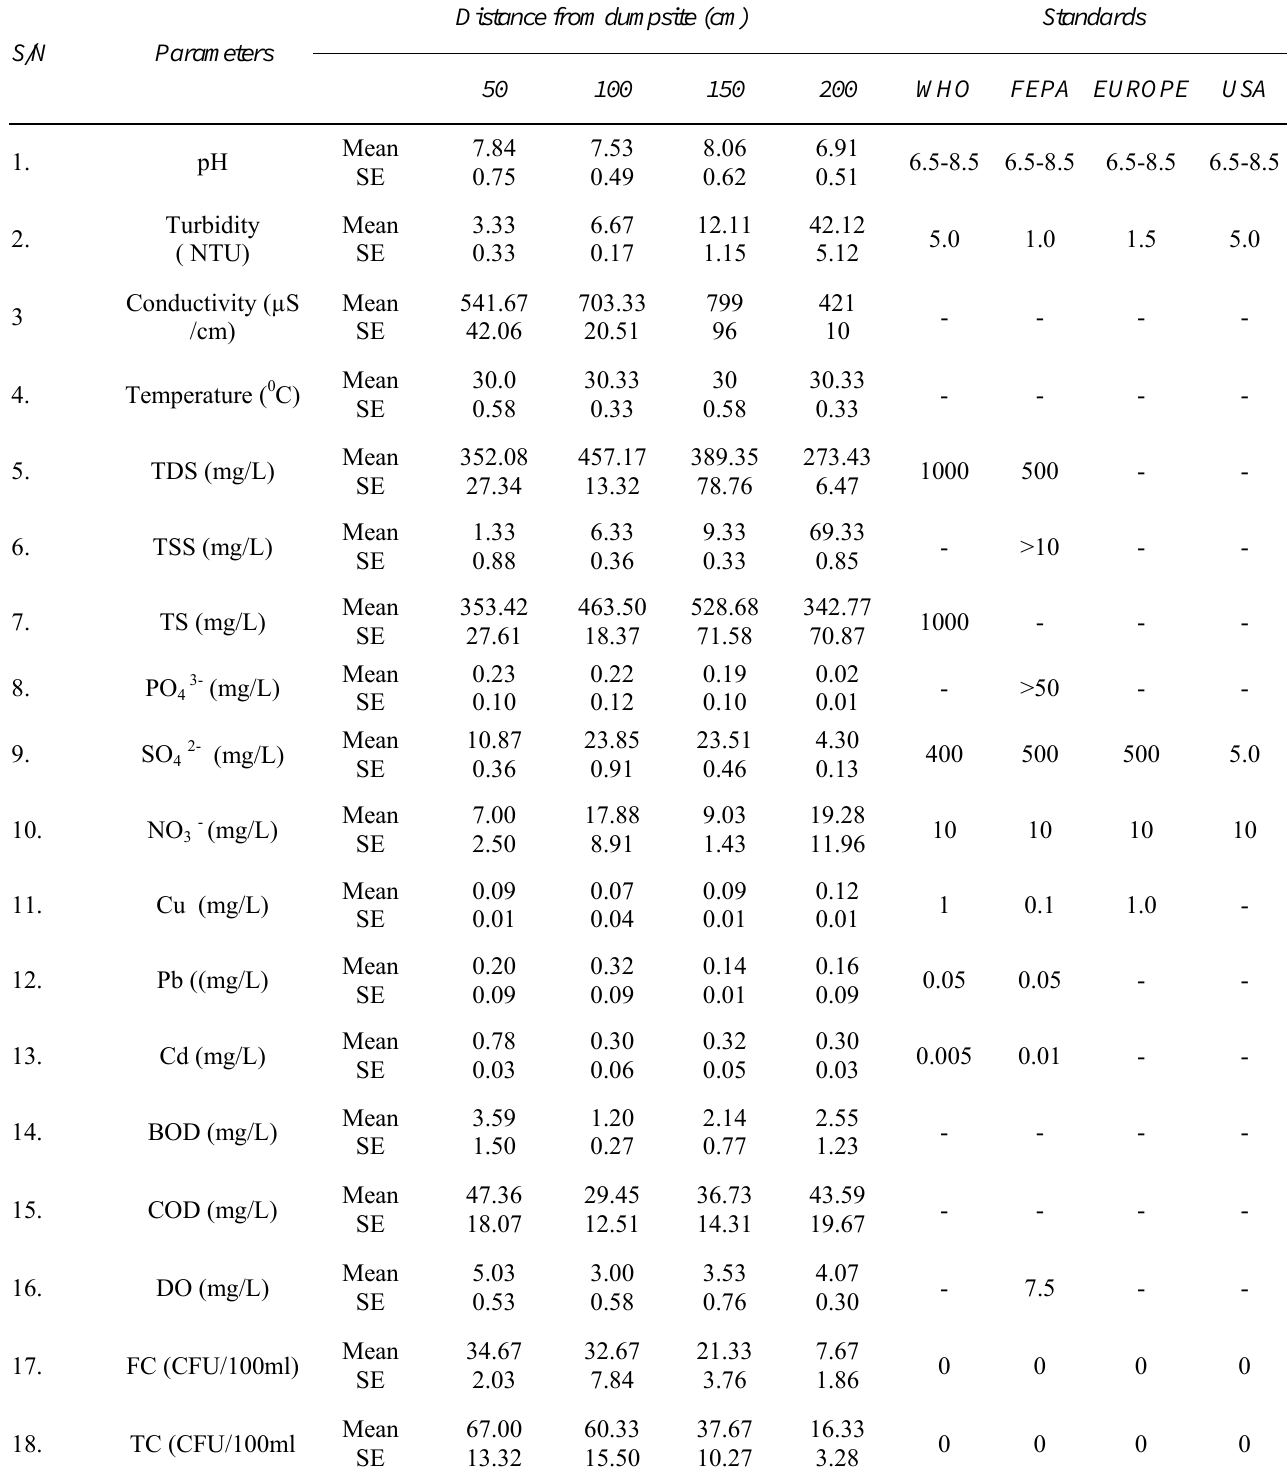
Table 1 : Mean values for the water quality parameters of wells located close to waste dumpsite in dry season.